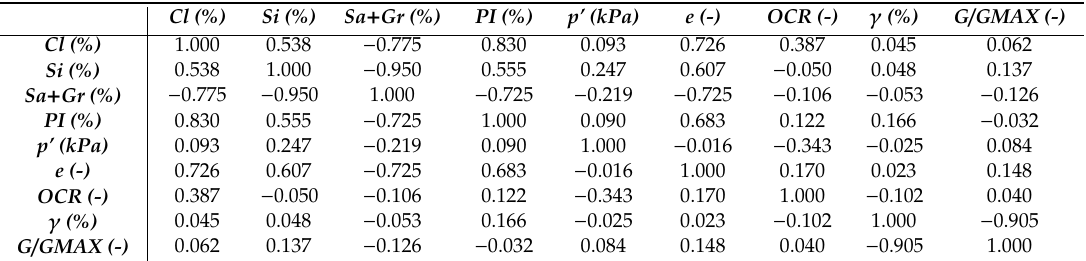
Table 6. Correlation matrix for tested soils, where Cl, Si and Sa + Gr is the clay, silt and sand and gravel content.